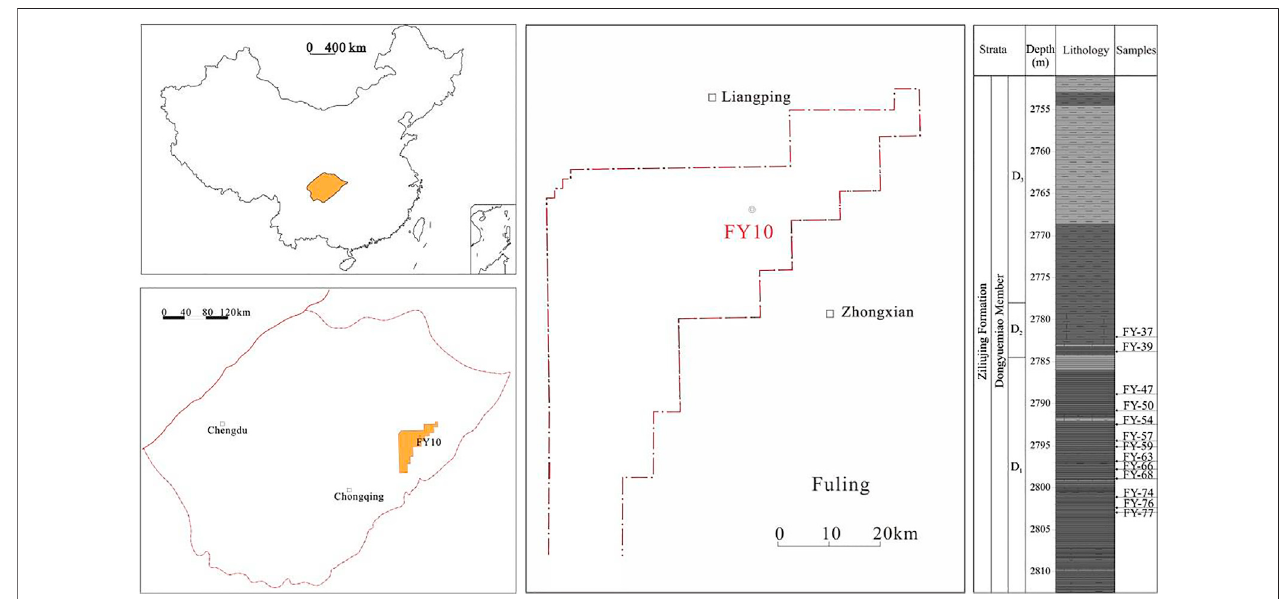
FIGURE 1 | Geologic map and stratigraphic column of the Dongyuemiao shale and the sampling sites in the Fuling area in the eastern Sichuan Basin, China.